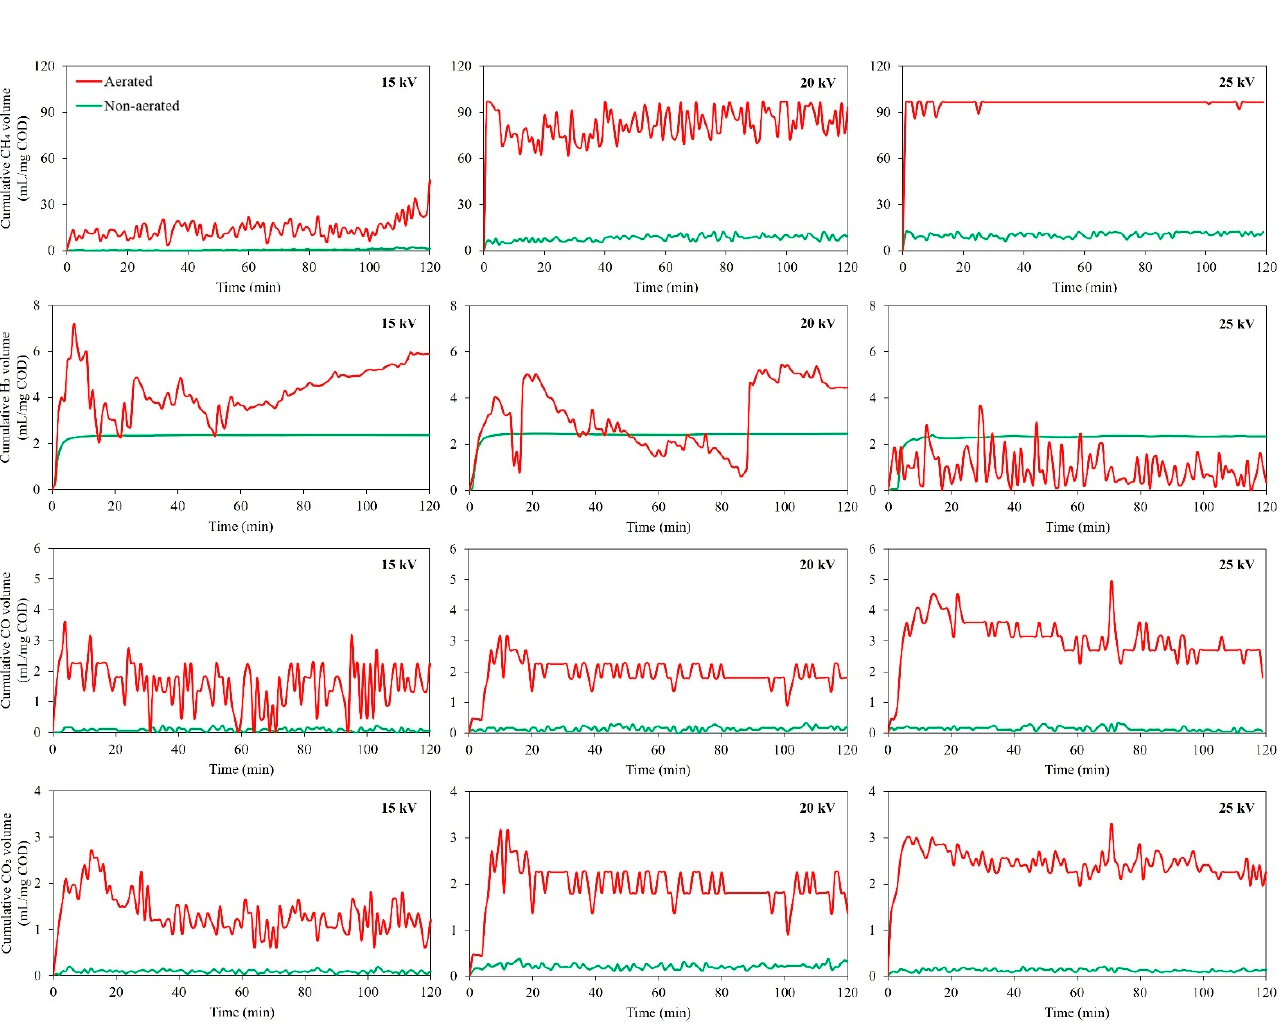
Figure 2. Cumulative biogas volume from POME assisted by DBD treatment under aerated and non-aerated conditions at different discharge voltages of 15, 20, and 25